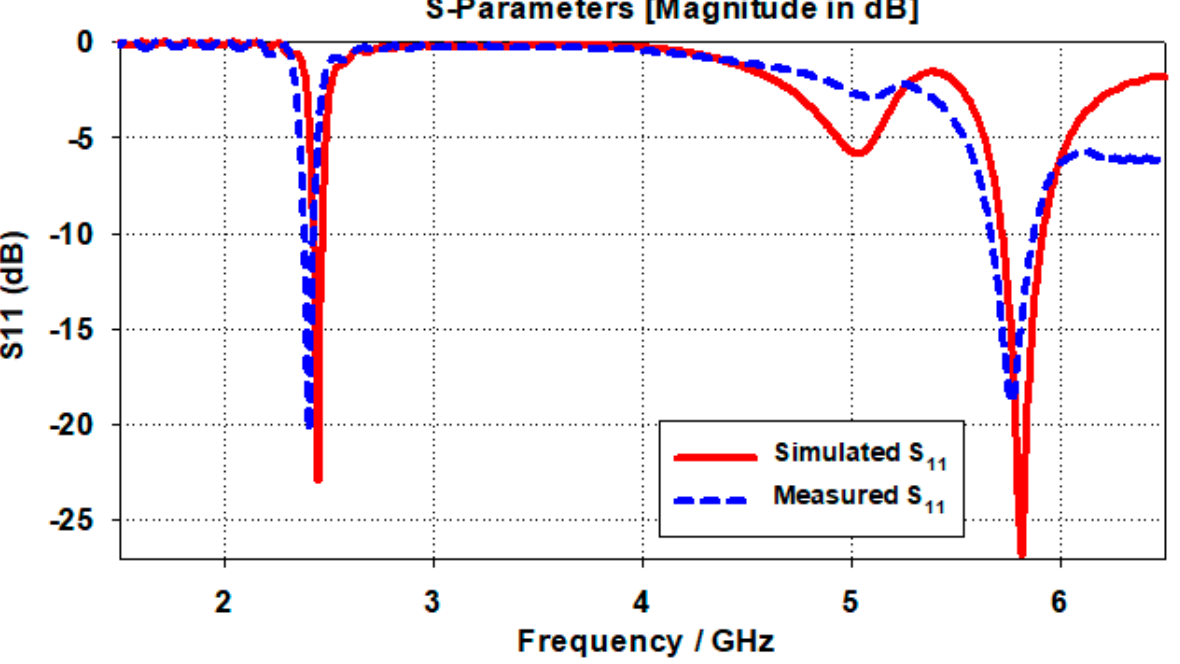
Figure 23. Simulated and measured reflection coefficient ( S 11 (dB)) of the proposed antenna.